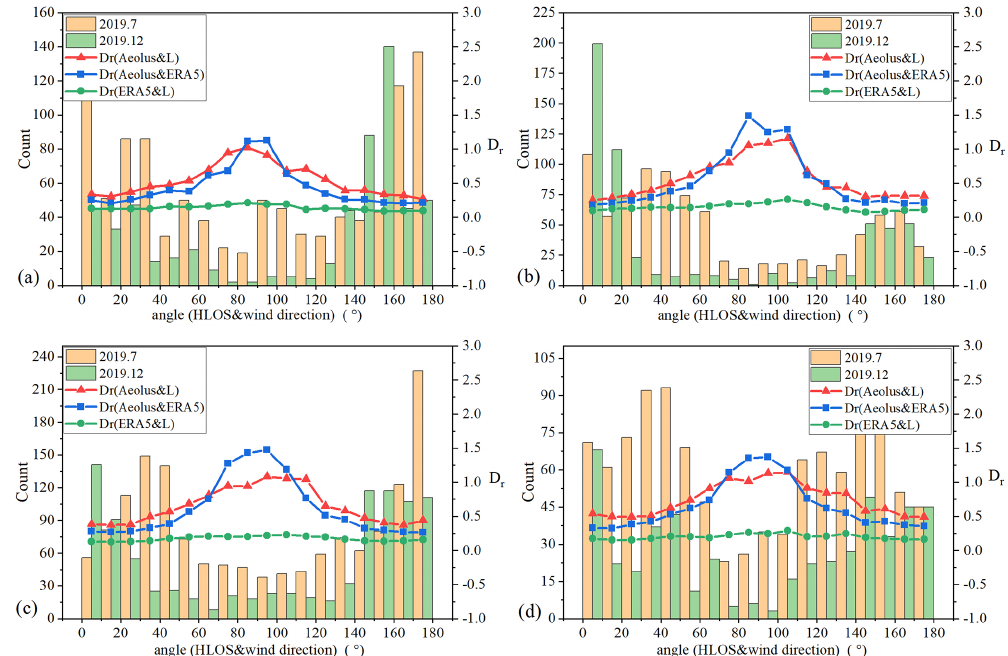
Figure 11. Statistical distribution at different angles (HLOS and wind direction) about the data points and mean relative errors from the Mie-cloudy group data. The relative error D r in the figure was calculated from the 12-month data of the region; (a) Chifeng, (b) Baoshan, (c) Shapingba, and (d)